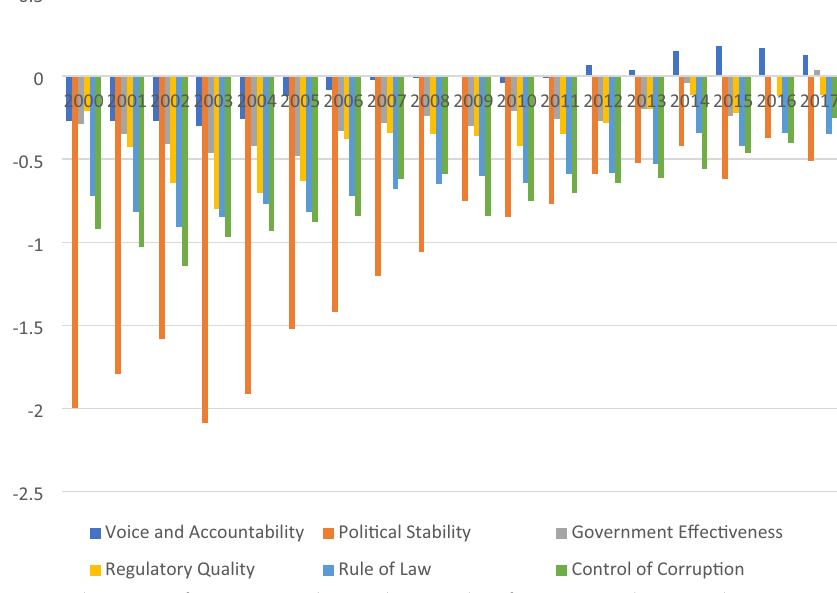
Fig. 2 Six dimensions of institutions quality in Indonesia. Value of institution quality is an index ranging from 2.5 to 2.5, with a score of 2.5 representing the strongest institutions. Source: Worldwide Governance − Indicators